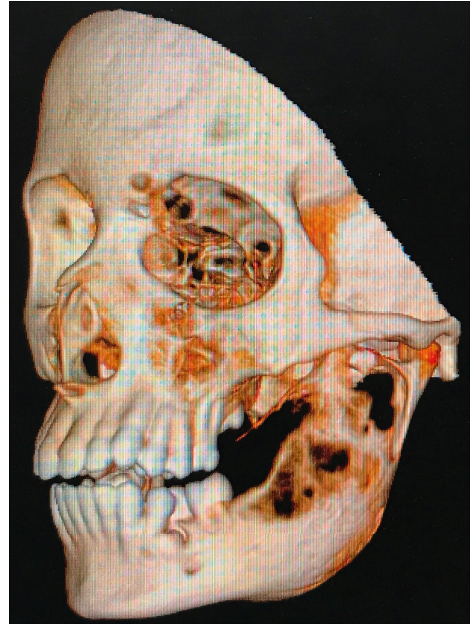
Figure 6: CTscan showing expansile lytic lesion of left ramus of the mandible.